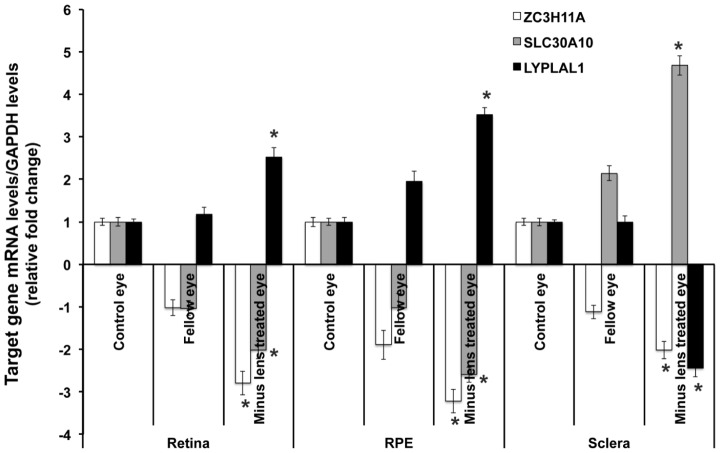
Transcription quantification of ZC3H11A, SLC30A10, and LYPLAL1 in mouse retina, retinal pigment epithelium, and sclera in induced myopic eyes, fellow eyes, and independent control eyes.Myopia was induced using −15 diopter negative lenses in the right eye of mice for 6 weeks. Uncovered left eyes were served as fellow eyes and age-matched naive mice eyes were controls. Quantification of mRNA expression in mice neural retina (retina), retinal pigment epithelium (RPE) and sclera using quantitative real-time PCR. The bar represents the fold changes of mRNA for each gene after normalization using GAPDH as reference. The mRNA levels of murine ZC3H11A, a gene that is conserved with respect to ZC3H11B in human, SLC30A10 and LYPLAL1 in myopic and fellow retina, RPE and sclera are compared with independent controls with P-values as follows: ZC3H11A (retina/RPE/sclera, P = 2.60×10−5, 2.62×10−6 and 1.08×10−4 respectively), SLC30A10 (P = 2.00×10−4, 2.00×10−4 and 4.02×10−4 respectively) and LYPLAL1 (P = 1.50×10−4, 1.50×10−4, 1.54×10−4 respectively). *P<0.0001.